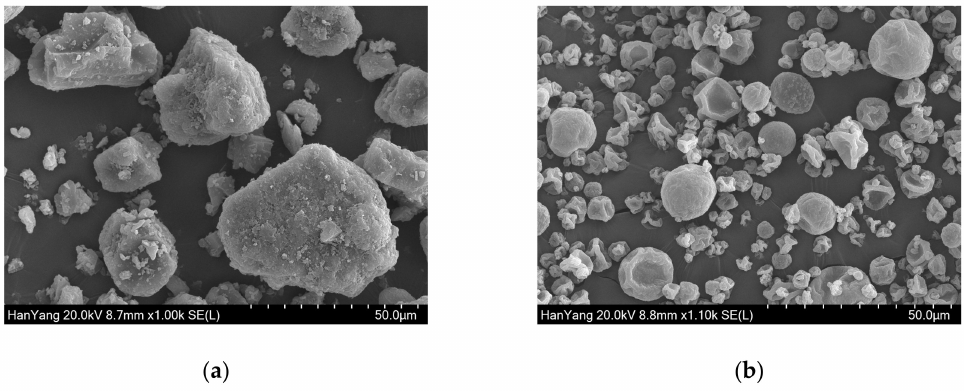
Figure 1. SEM images of ( a ) curcumin and ( b ) DW-CUR